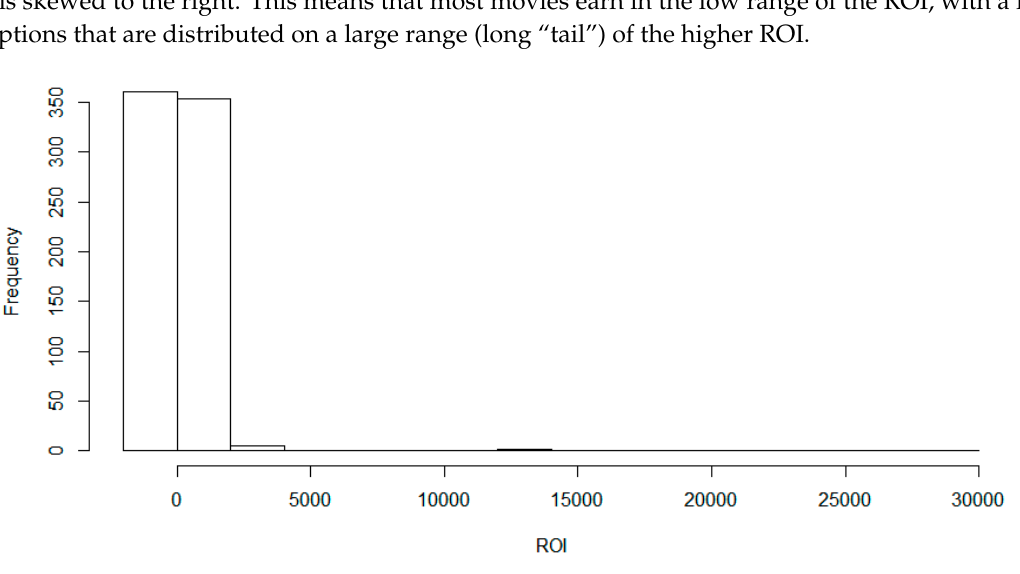
Figure 2. Histogram of ROI during Years 2010–2015. Unit of Horizontal Axis is Percent (%) and Vertical Axis is Frequency.